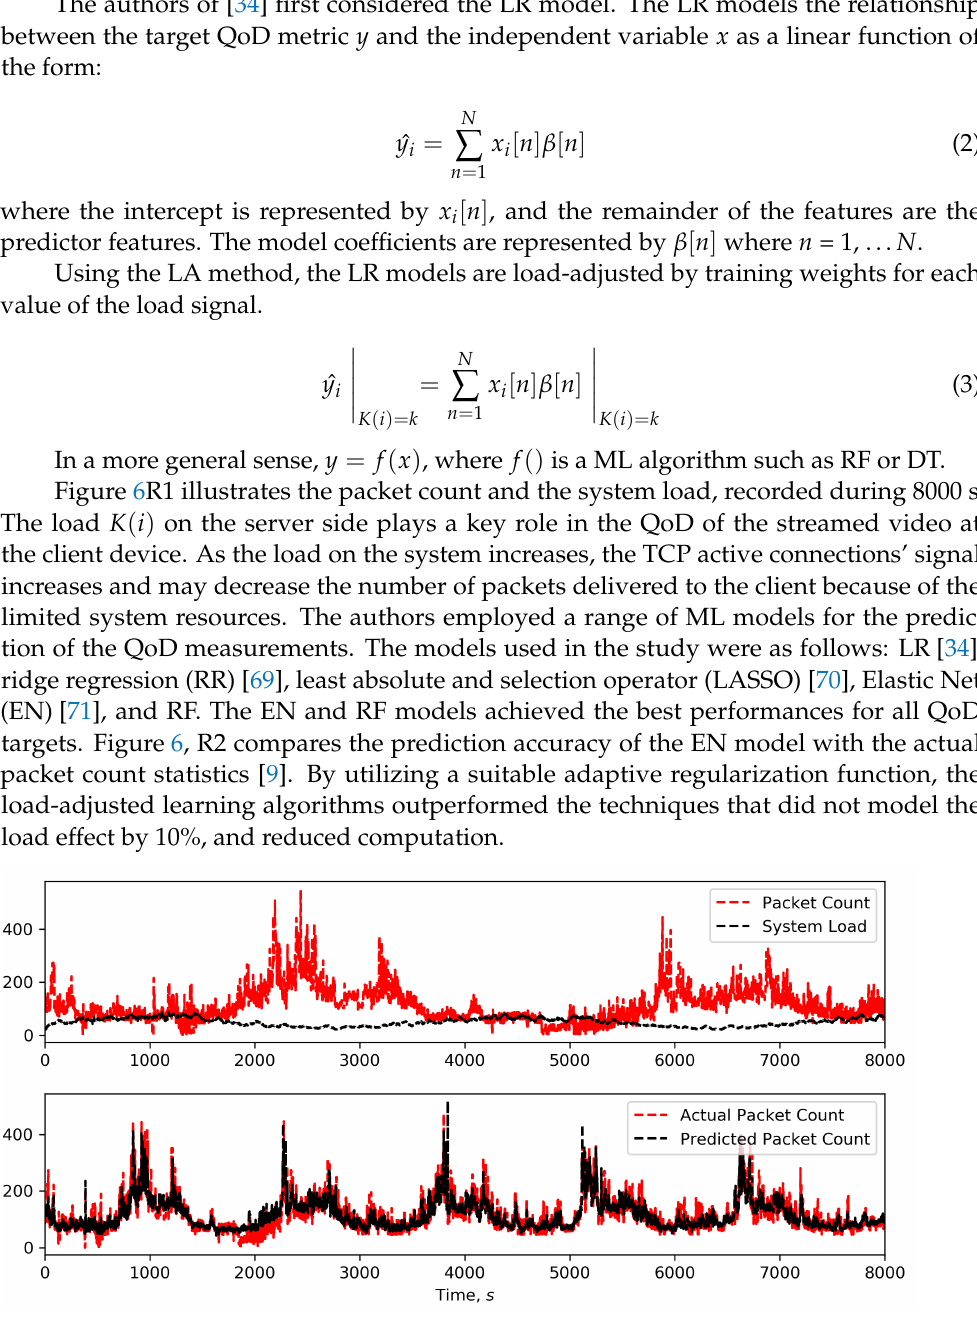
Figure 6. Row 1 (R1): The packet count, y , is illustrated for 8000 s along with the system load. The load signal is a feature of x . There is a periodic change in request patterns. The load signal increases as the packet count decreases, which illustrates the dependencies between the two statistics. Row 2 (R2): The actual packet count statistics are compared to the predicted packet